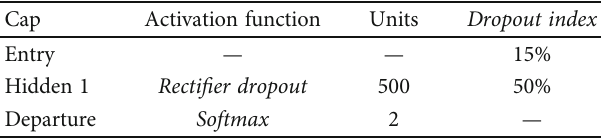
Table 19: Higher precision model for Hospital set: deep learning with balanced data, hyperparameters. Learning rate = 0 : 005 , 2611